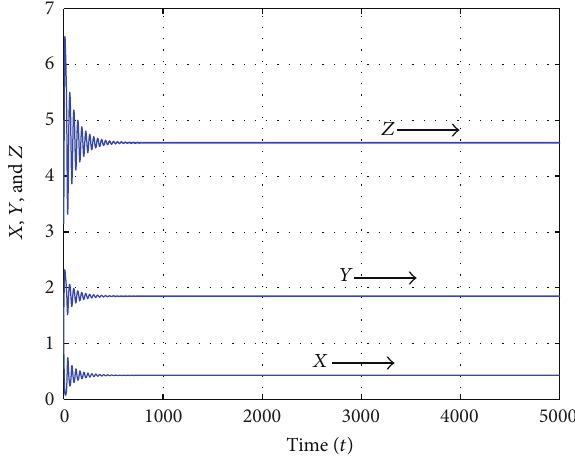
Figure 3: Time series plot of 𝑋 , 𝑌 , and 𝑍 for nonzero exogenous input ( 𝛾 = 1.25 ) and ℎ𝑝𝑞 > 𝛾 with 𝑋(0) = 1 , 𝑌(0) = 1 , and 𝑍(0) = 5 ; parameter values are given in Table 1.